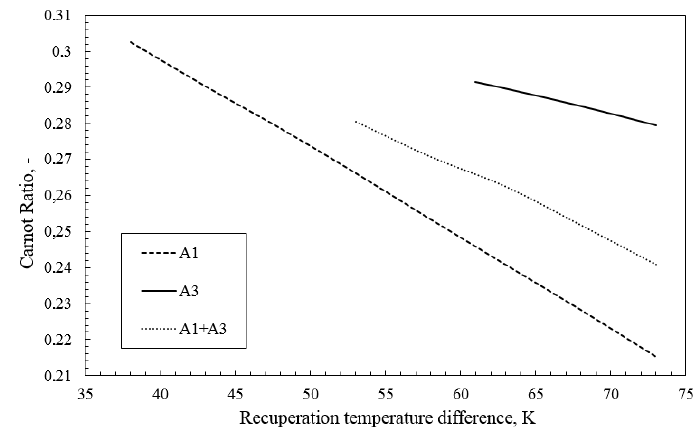
Figure 10. The limiting Carnot efficiency of flammable (A3: R290, R1150, R50), nonflammable (A1: R125, R23, R14) and mixed (A1+A3: R125, R1150, R50) refrigerant configurations with respect to recuperation temperature difference.